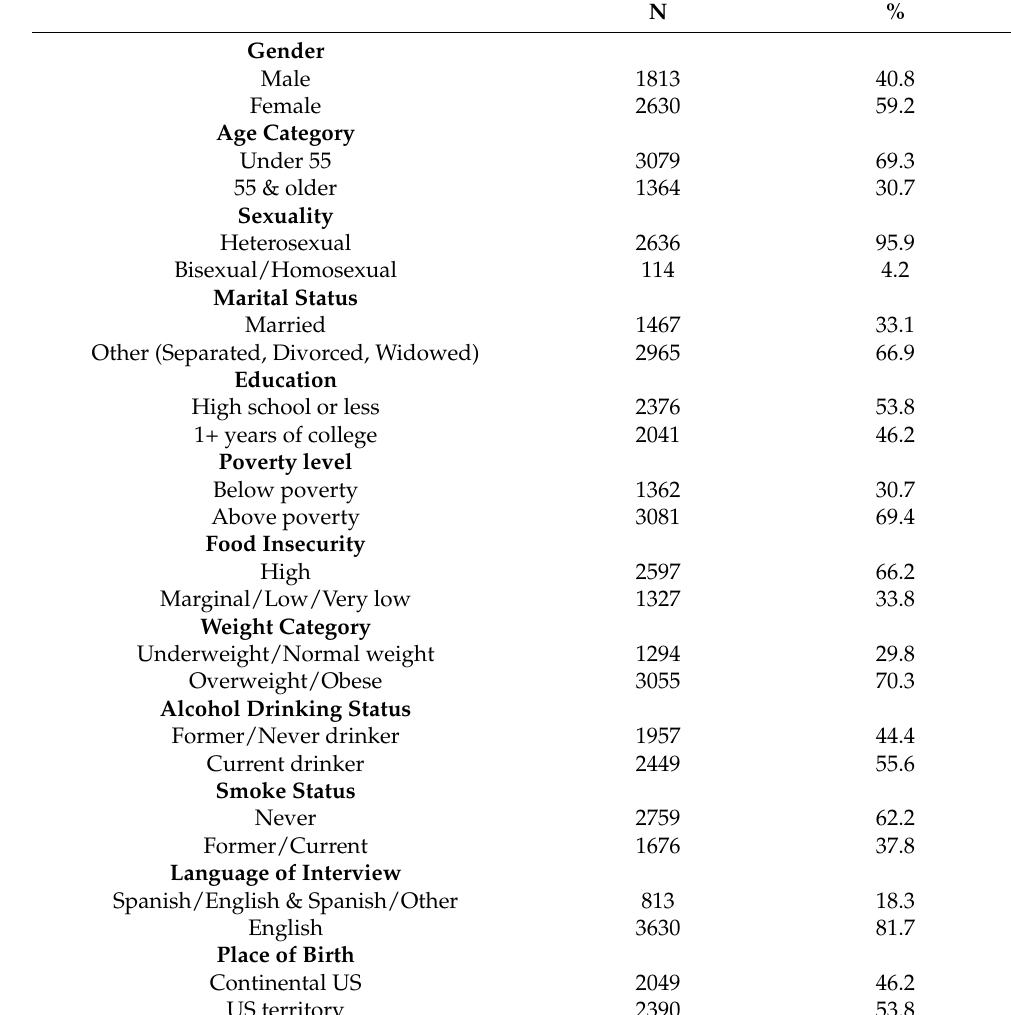
Table 1. Sample demographics (N = 4443).